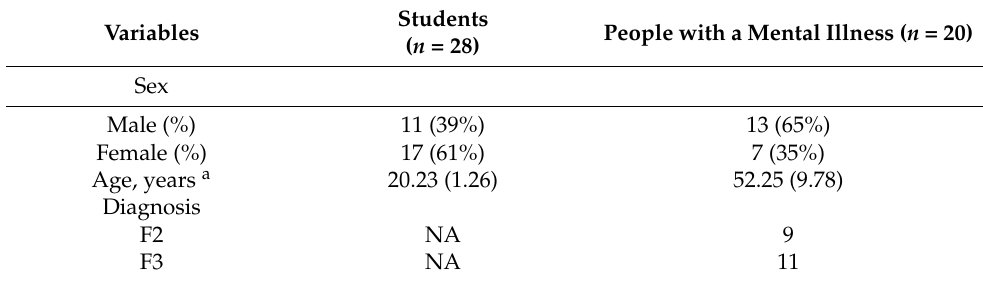
Table 1. Characteristics of the CPD-RS participants.